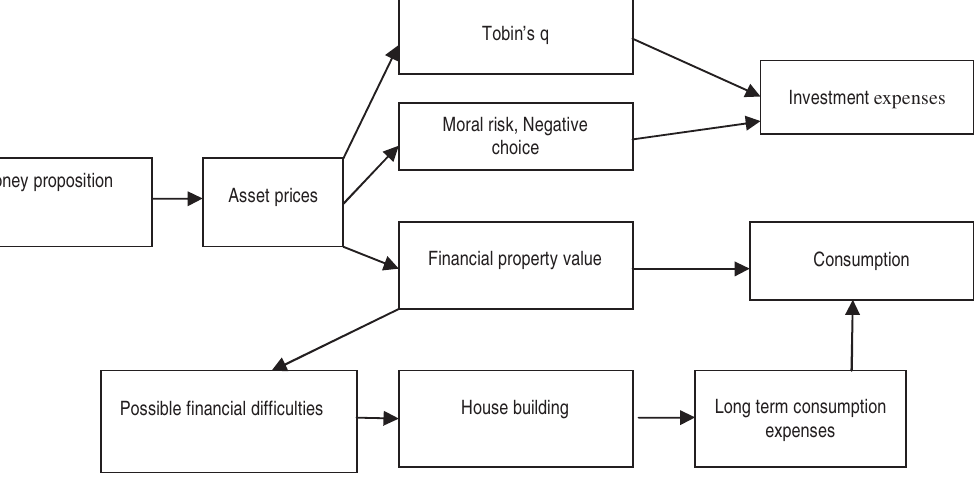
Fig. 3. Asset price channel incorporation in the transmission mechanism of monetary policy of